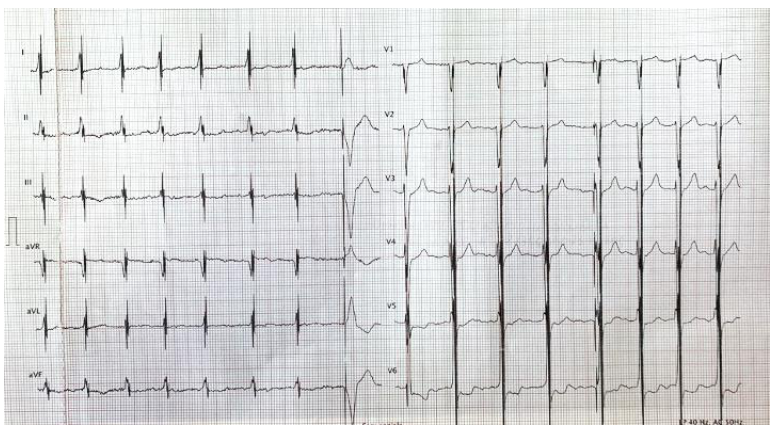
Figure 3. Electrocardiogram with visible spikes of high-energy impulses from CCM therapy.